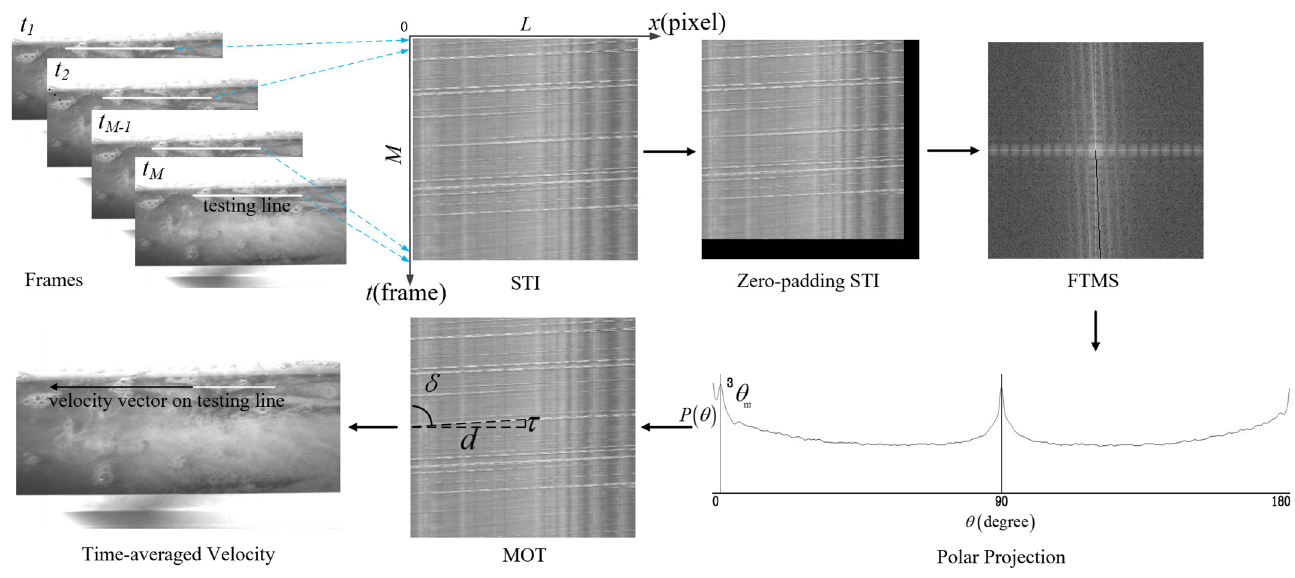
Figure 1. Outline of FFT-STIV.